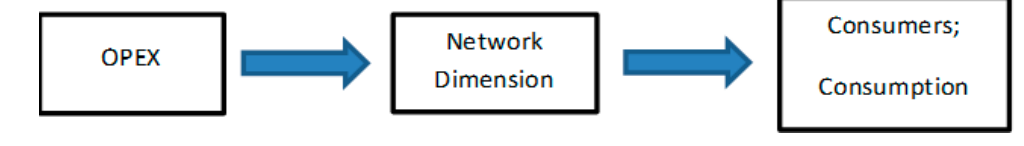
Figure 2. Diagram of DEA model.